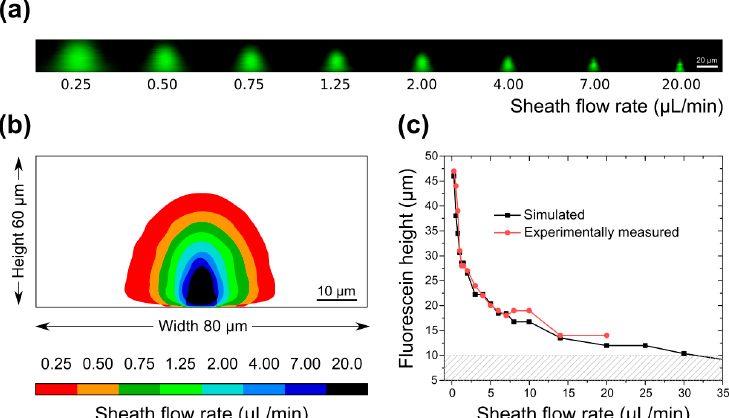
Figure 3. ( a ) Confocal microscopy images at increasing sheath-to-sample flow velocity ratio for 10 + 50 µ m device. As sheath flow rate increases, fluorescein is confined both towards the microscope ( b ) Z-projection of thresholded confocal microscopy images showing fluorescein confinement for increasing sheath flow rate; ( c ) Simulated (black) and experimentally measured (red) fluorescein heights for constant fluorescein flow rate of 0.25 µ L / min and varying sheath flow rates. Shaded area highlights fluorescein height below 10 µ